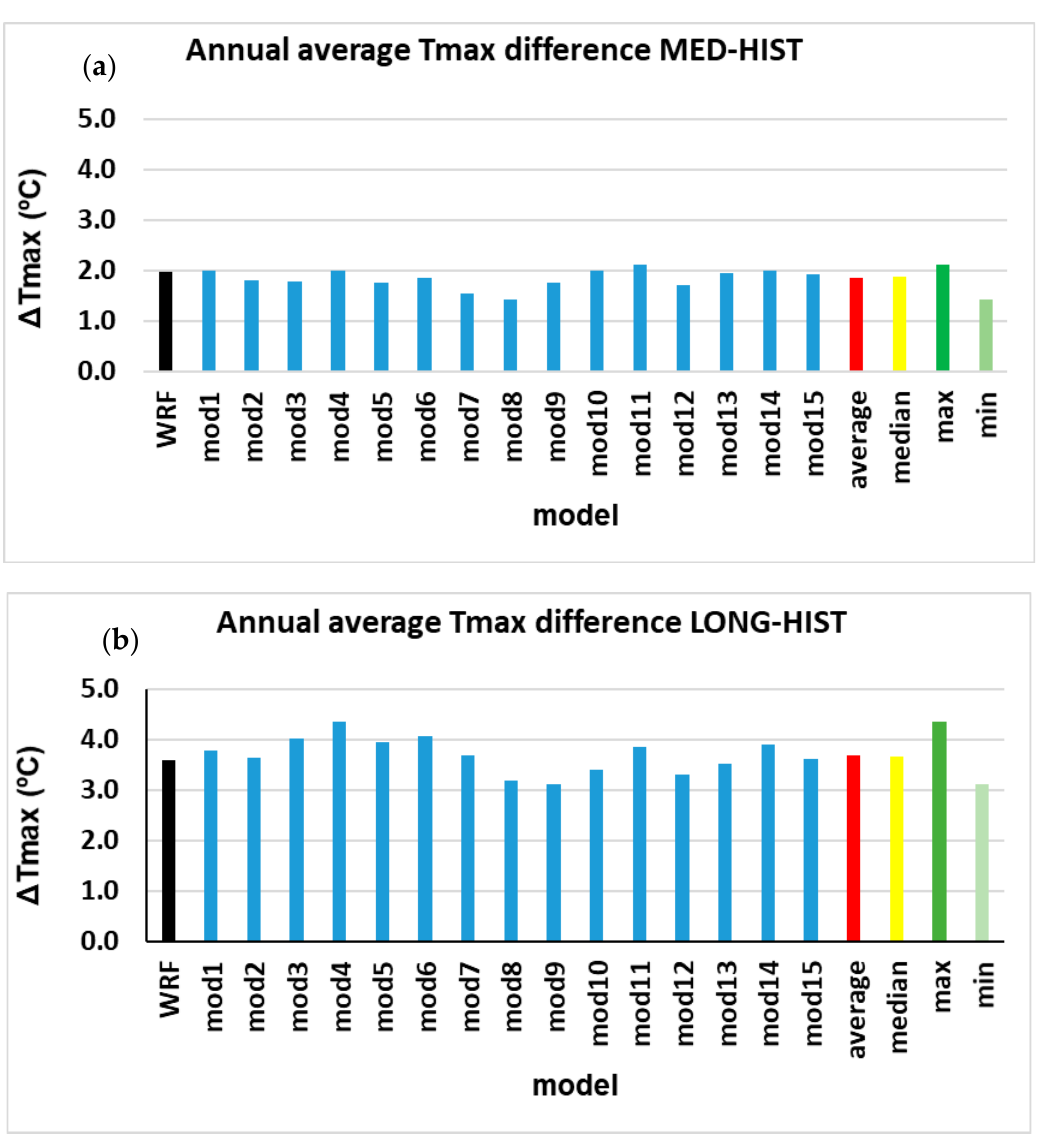
Figure 9. Annual average Tmax difference ( a ) MED-HIST and ( b ) LONG-HIST, for WRF and average, maximum, and minimum CORDEX models.